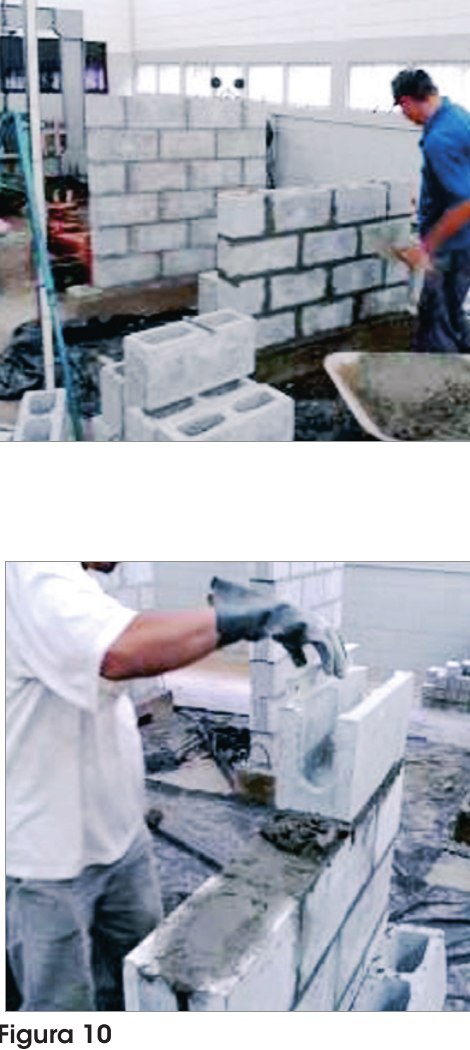
Ilustração das paredes ocas (sem grauteamento) Ilustração das paredes grauteadas com cinta a meia